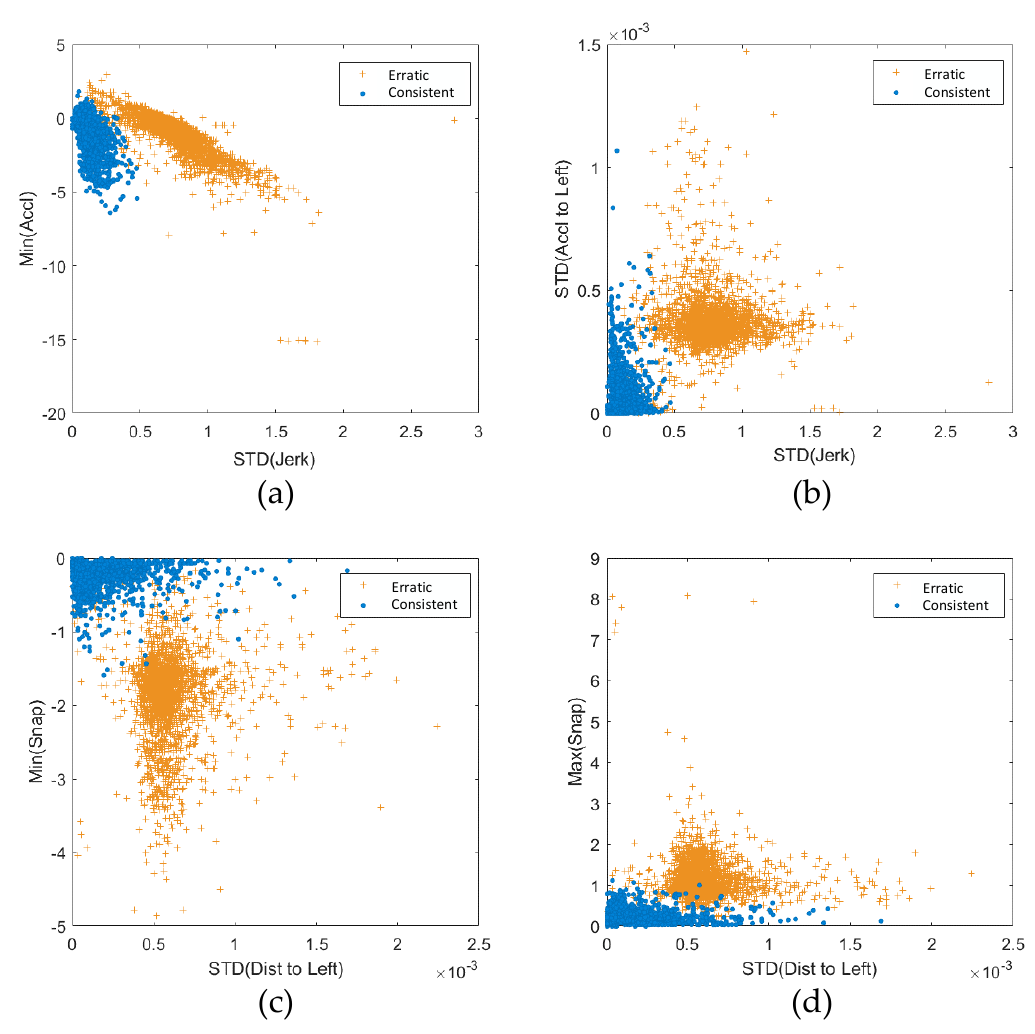
(f) Figure 6. Kinematic behaviors grouping. The algorithm can provide two probabilities, i.e., ( ) 1 i p and ( ) 2 i p that indicate the chances the driver belongs to each of the two clusters or distributions. Since the two posteriors indicate the probabilities of the driver belonging to a respective cluster, and they sum to one, they are naturally suitable for normalizing the two predictions made by the ensembled methods to find a new average.